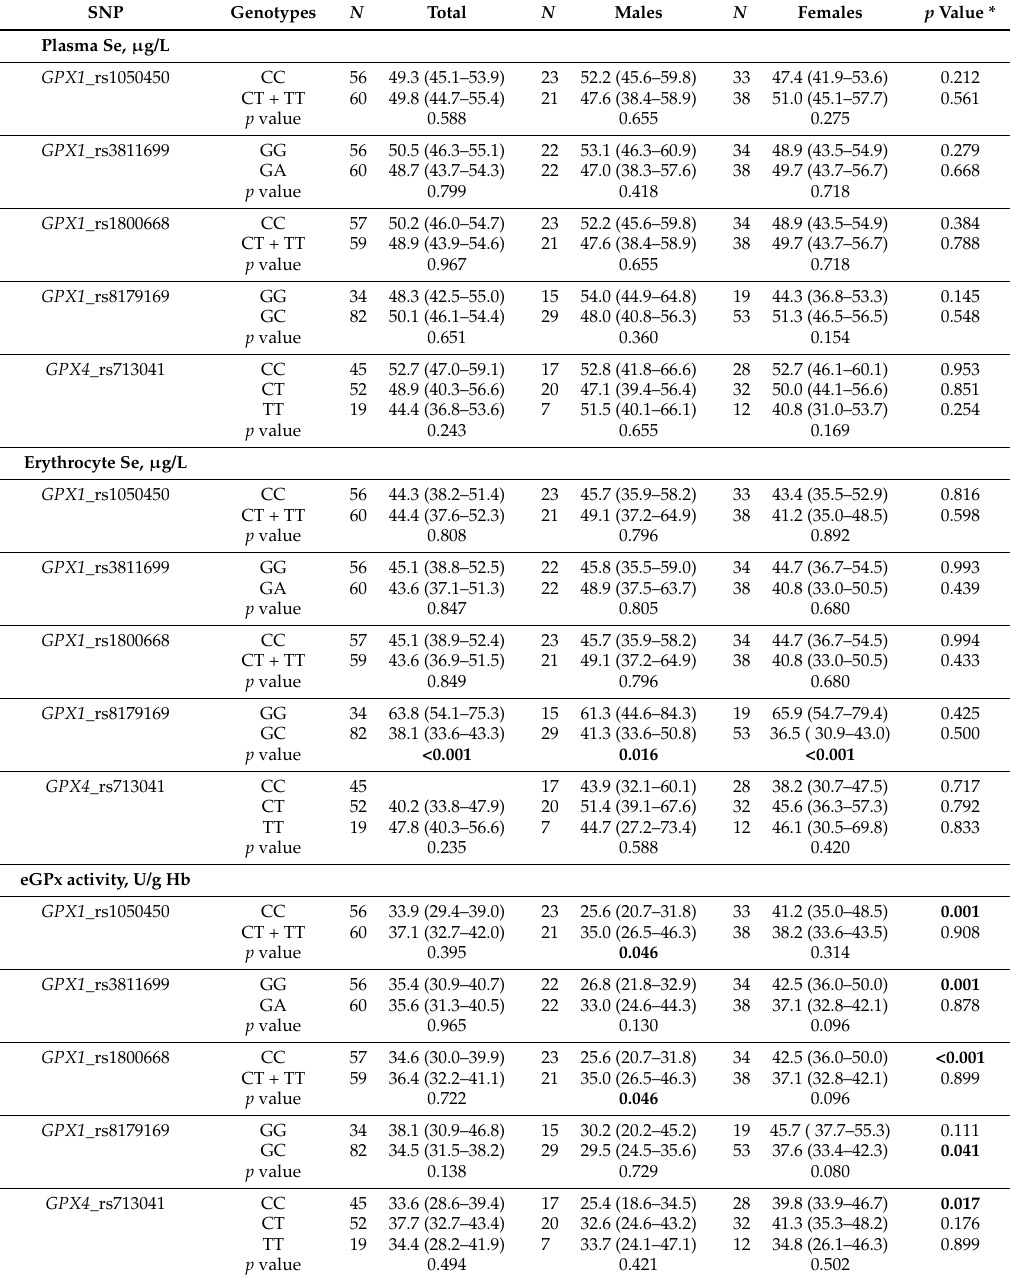
Table 3. Biomarkers of Se status according to gender and genotypes for GPX1 rs1050450,